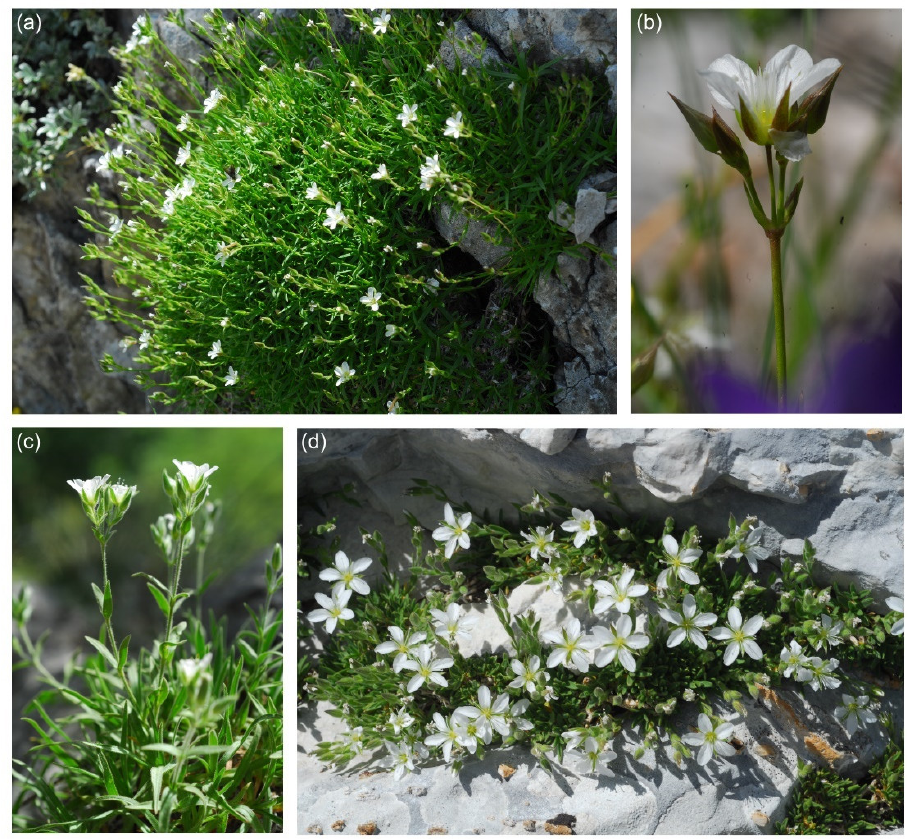
Figure 5. Photographs of some Mcneillia taxa observed in nature. ( a ) Mc. graminifolia subsp. clandestina (Pizzo Cefalone, Italy); ( b ) Mc. graminifolia subsp. clandestina , detail of the flowering stem (Montagna dei Fiori, Italy); ( c ) Mc. graminifolia subsp. rosanoi (Mt. Briccialone, Italy); ( d ) Mc. pseudosaxifraga (Mt. Nemercka, Albania). Photo credit: F. Conti.